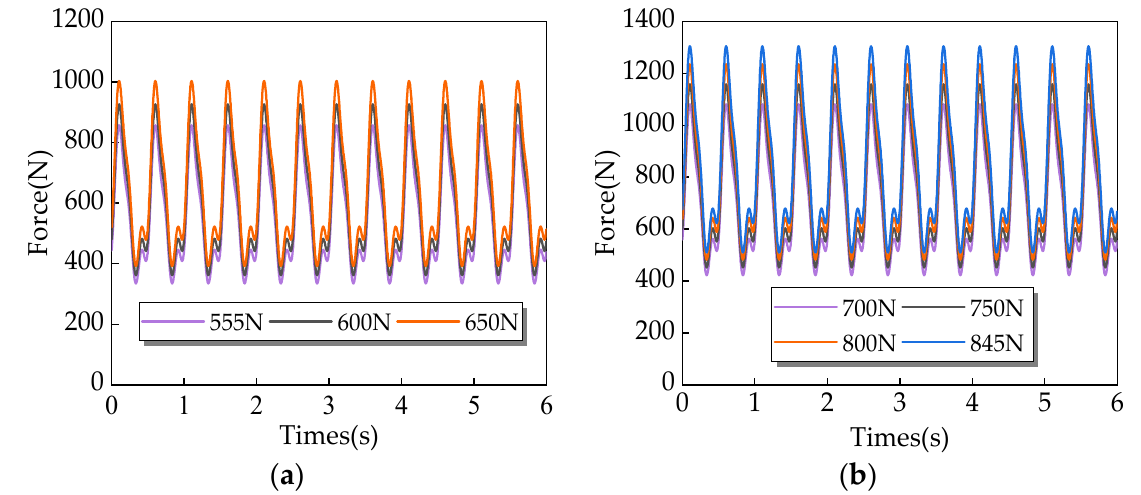
Figure 12. Pedestrian loads with different human weights: ( a ) human weights of 555 N, 600 N, and